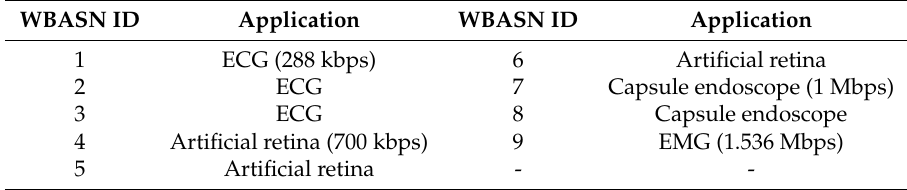
Table 4. Applications used by WBASNs in the